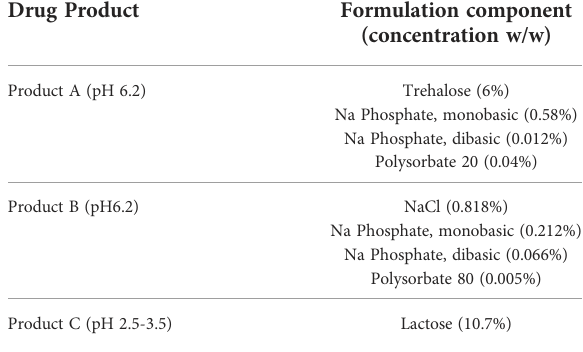
(concentration w/w)